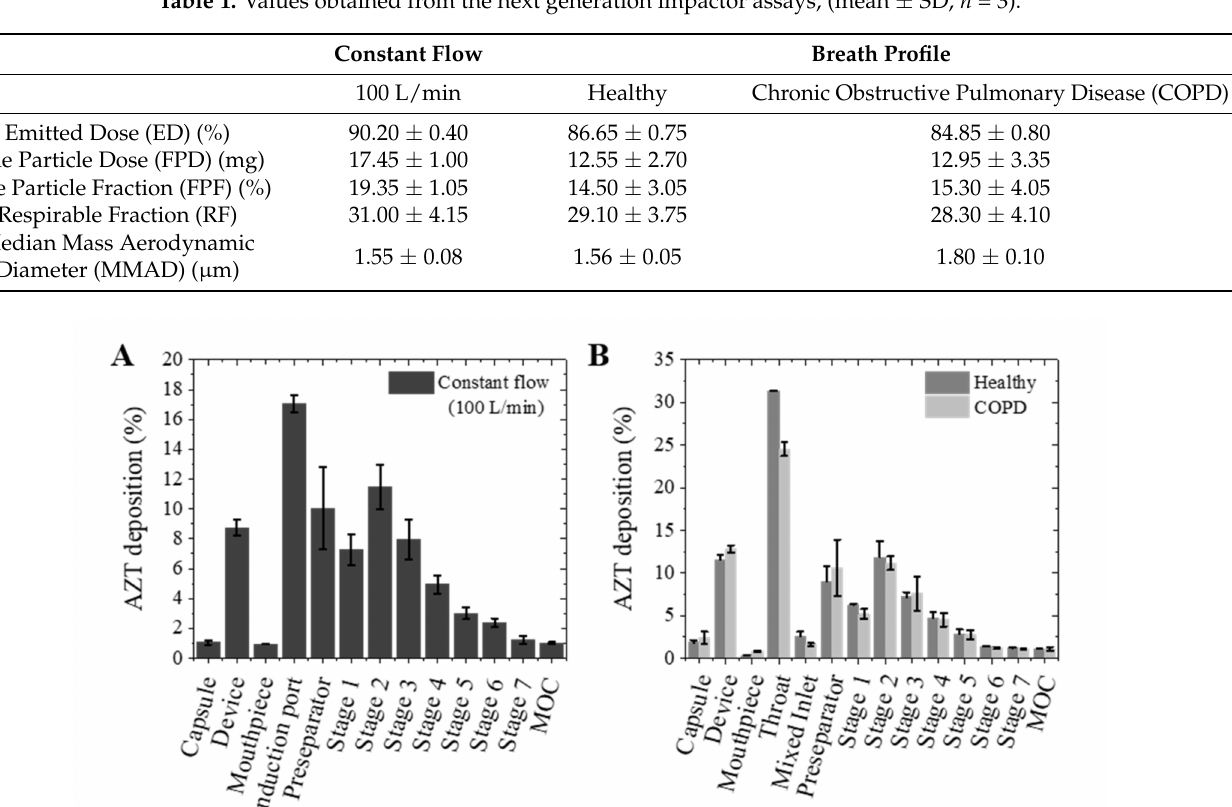
Table 1. Values obtained from the next generation impactor assays, (mean ± SD, n = 3).